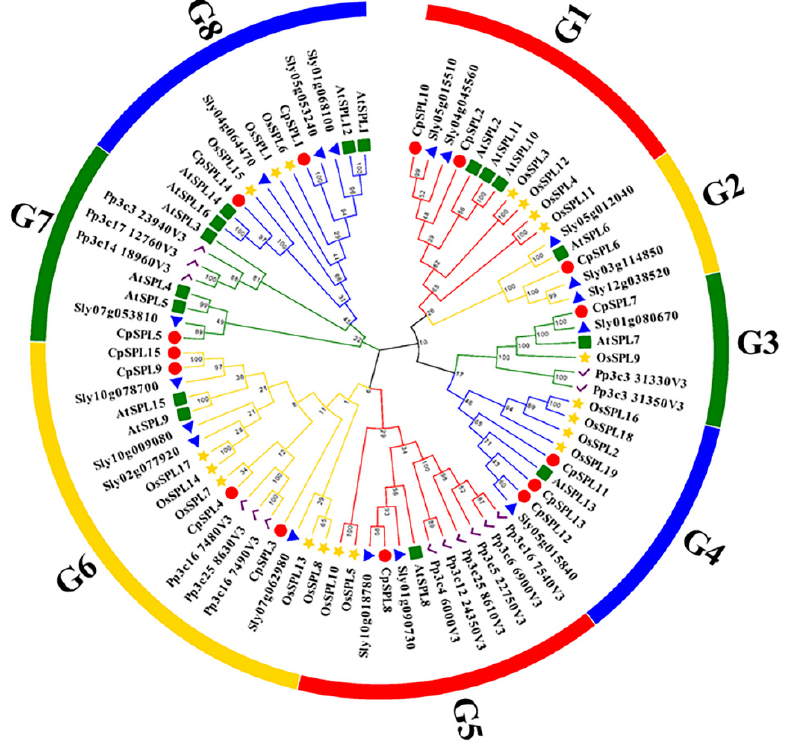
Figure 1. An NJ phylogenetic tree of the SPLs from Codonopsis pilosula , Arabidopsis thaliana , Solanum lycopersicum , Oryza sativa and Physcomitrella patens .